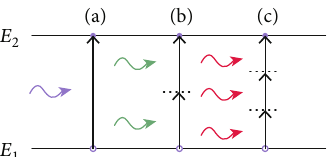
Figure 1: Energy level diagrams of one- (a), two- (b), and three- (c) photon absorption. Solid lines represent real arbitrary energy levels E 1 and E 2 ; dotted lines represent virtual